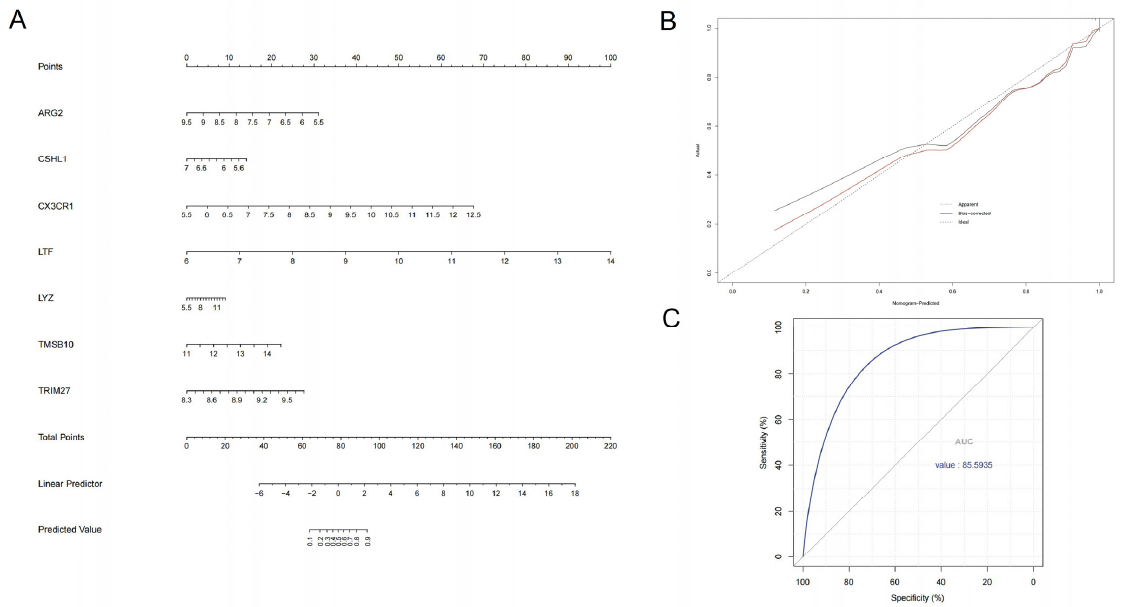
Figure 6. Construction and assessment of machine learning model. ( A ) Nomogram model for GN diagnosis, based on the 7 DIRGs ( ARG2, CSHL1, CX3CR1, LTF, LYZ, TMSB10, TRIM27 ). ( B ) Calibration curve to evaluate the nomogram model. The actual GN risk and the predicted risk are very close. ( C ) The ROC curve to assess the nomogram model. The AUC value of the nomogram model in data 2 is 0.855935.